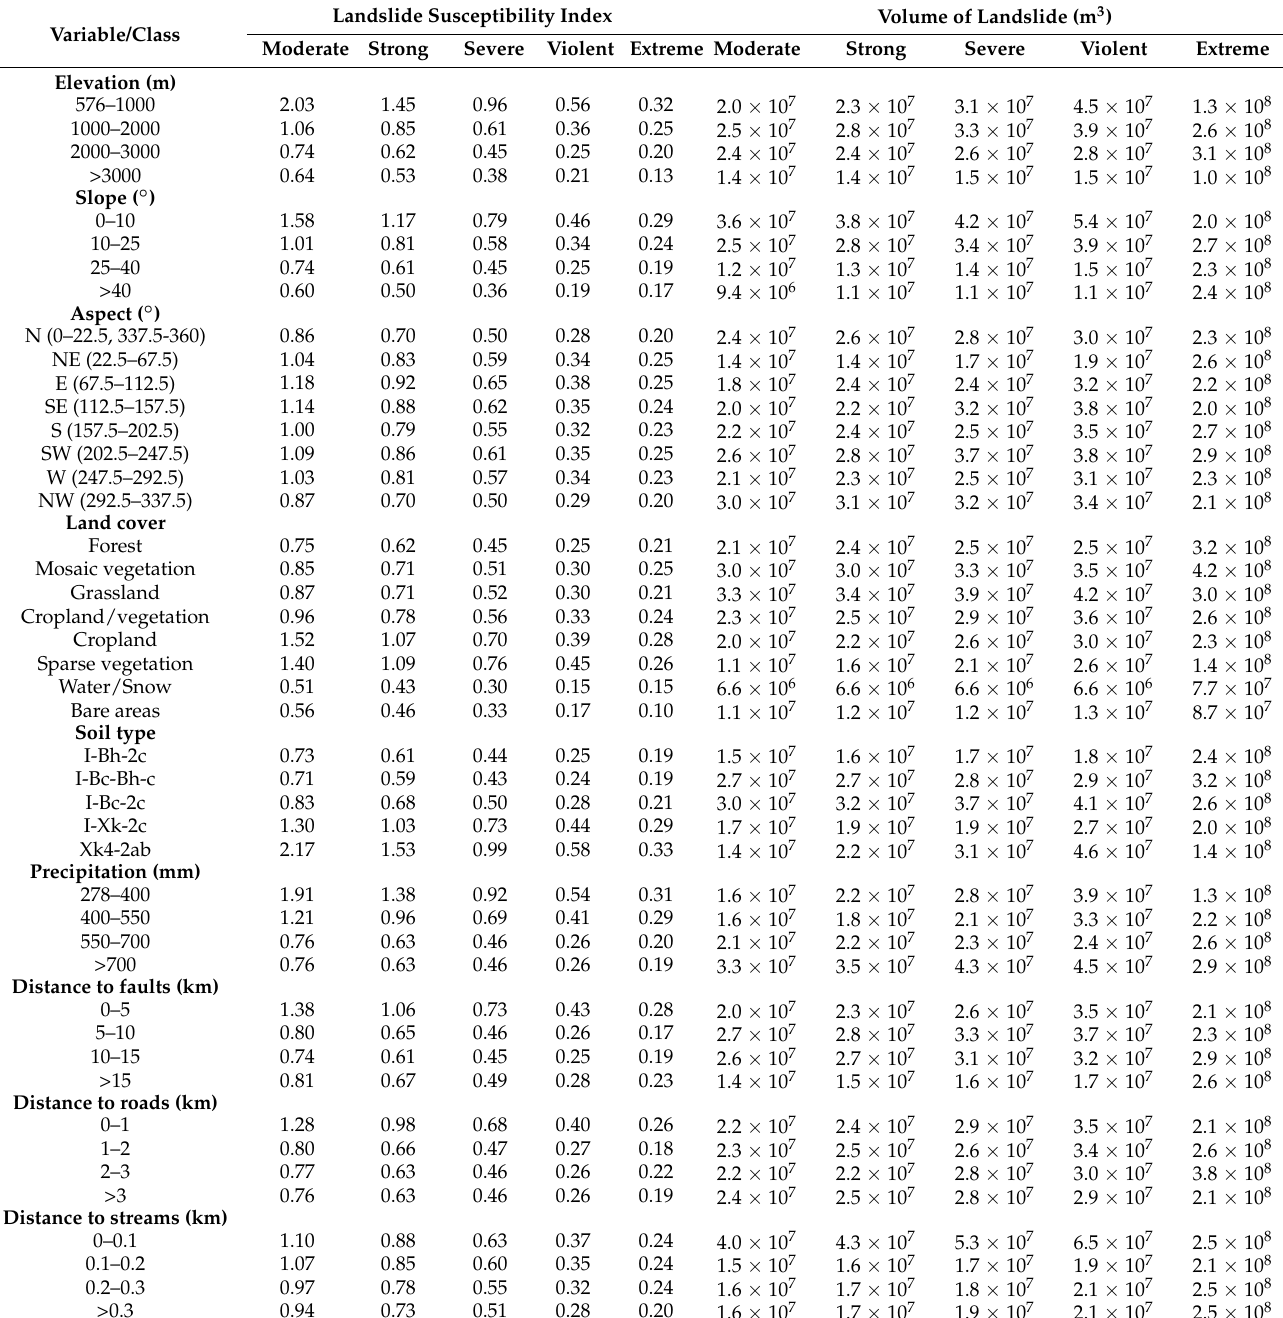
Table 3. Averages of landslide susceptibility index and volume of landslide across the classes of environmental variables under five earthquake